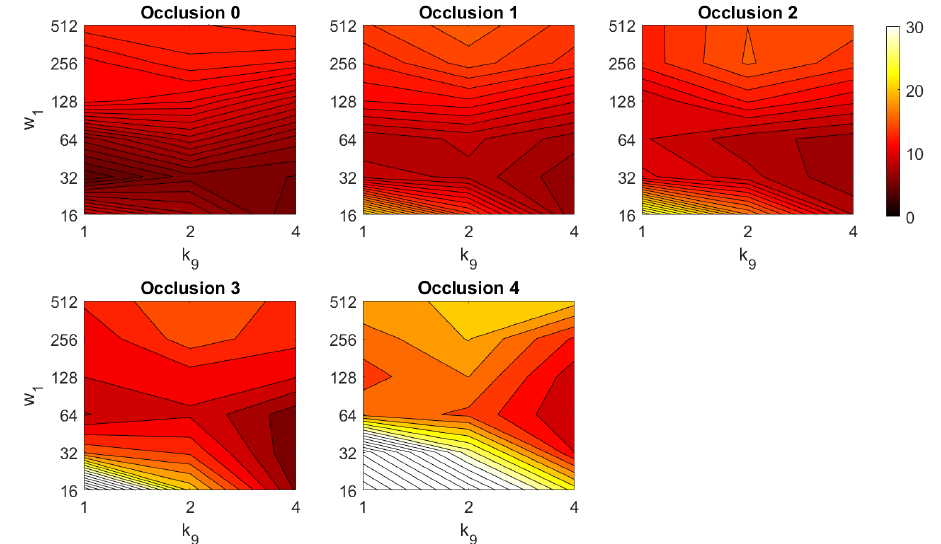
Figure 39. WS orientation estimation in the presence of occlusion. Average orientation error (deg).